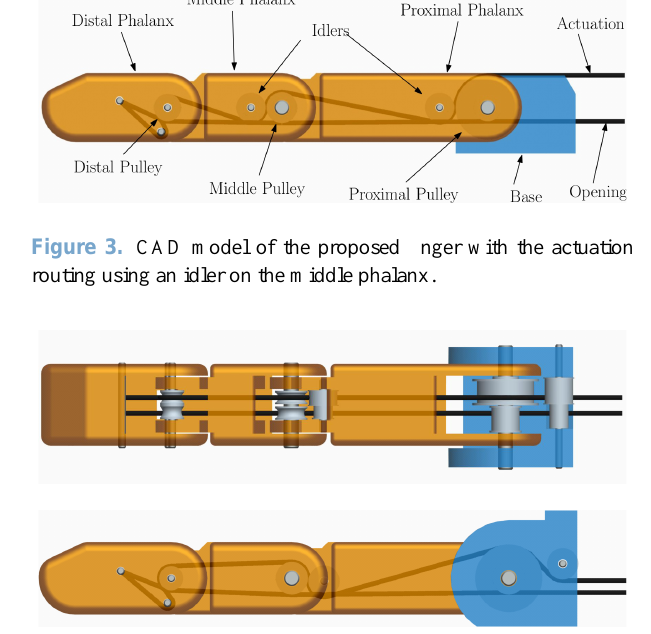
Figure 4. CAD model of the proposed finger with the actuation routing that does not require an idler on the middle